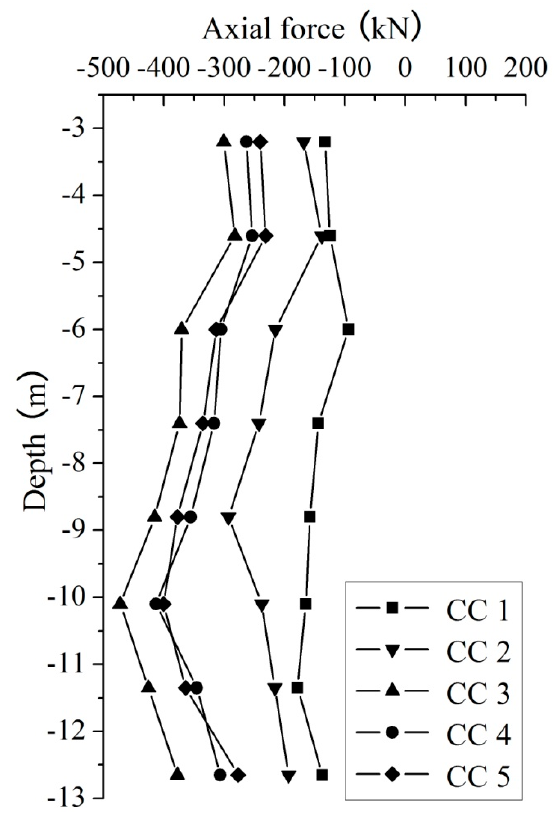
Figure 4. The axial force distribution curves of the H-shaped steel in the SMW pile Z1 under five construction conditions (construction condition is abbreviated “CC”).